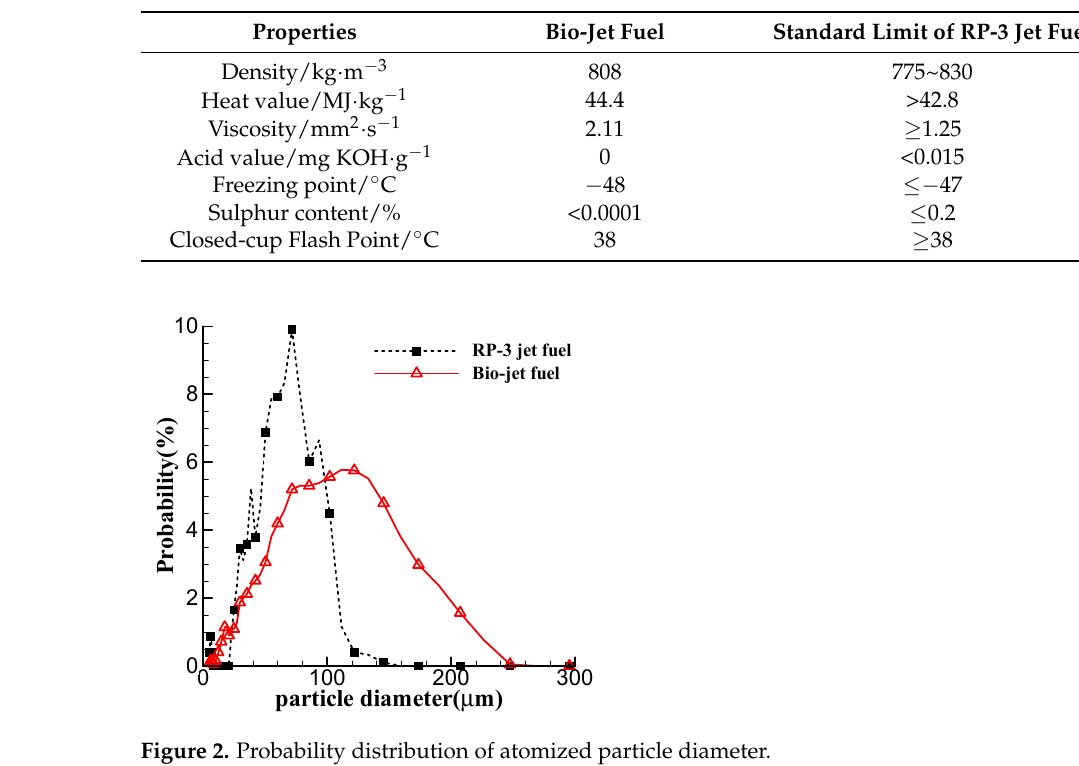
Table 2. Engine performance parameters.